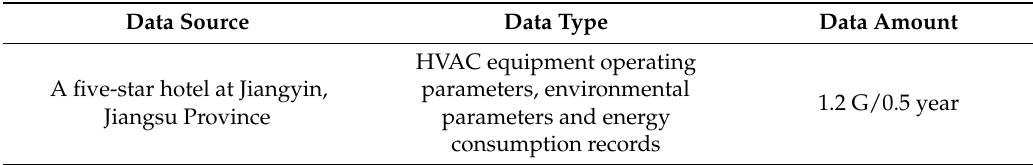
Table 2. Data description and